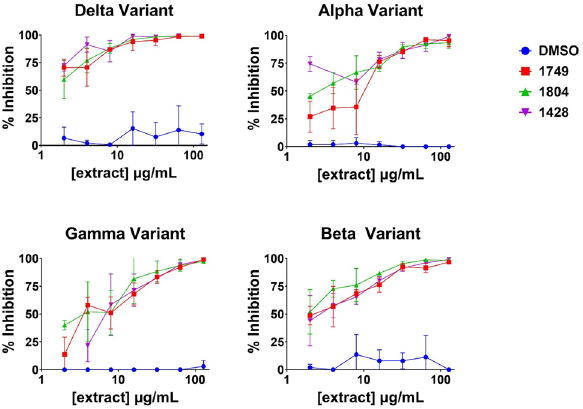
Figure 2. All variants were tested at a titer of 1.2 × 105: Gamma/P.1 variant (BPS Biosciences #78144-1), Beta/B.1.351 variant (BPS Biosciences #78142-1), Delta/B.1.617.2 variant (BPS Biosciences #78215-1), and